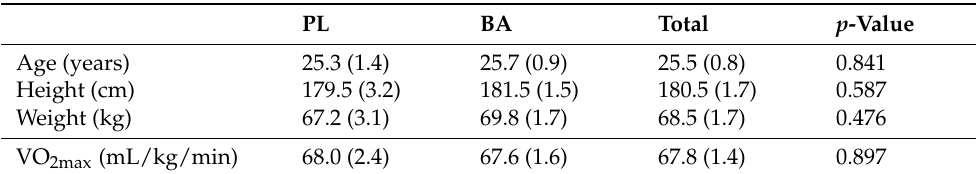
Figure 2. Participant flow chart. Table 1. World tour cyclist physical characteristics. Values are presented as mean with standard error of the mean inside brackets.